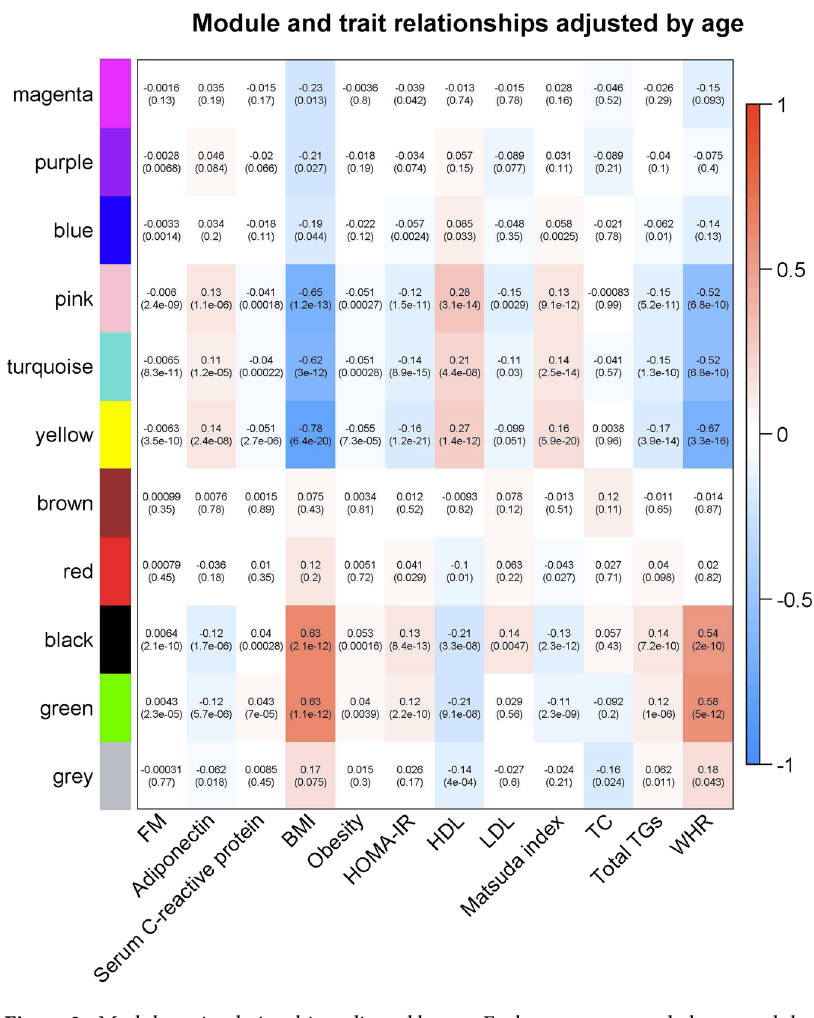
Figure 2. Module-trait relationships adjusted by age. Each row corresponded to a module eigengene, and each column to a trait. Numbers in the table report the age-adjusted correlations of the corresponding module eigengenes and traits, with the p-values printed below the correlations in parentheses. The table was color coded by correlation according to the color